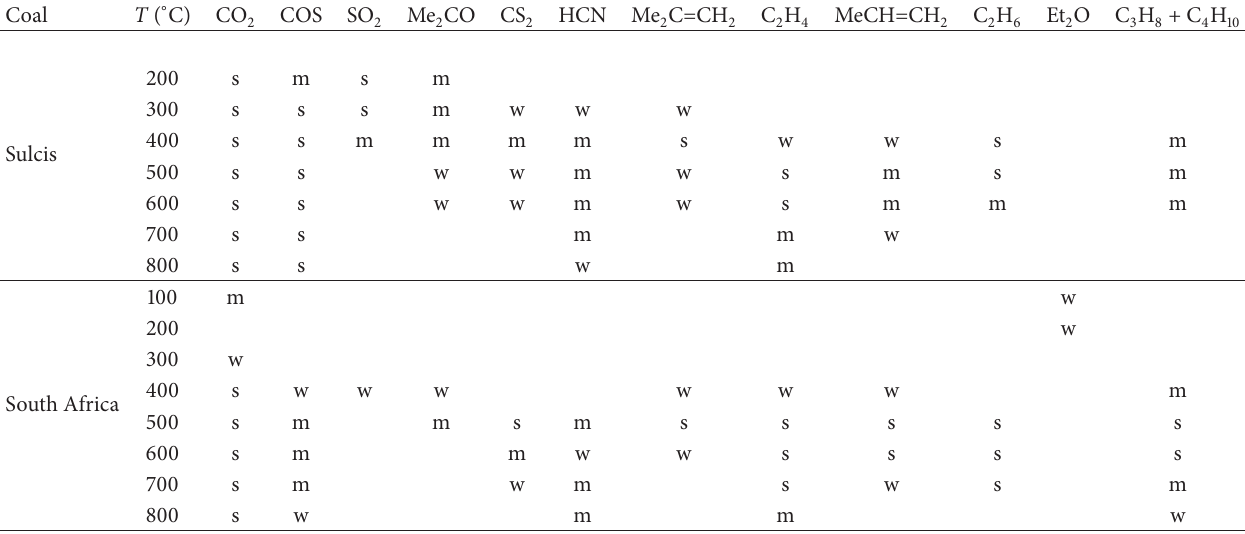
Table 4: Qualitative distribution of vapors collected in the cooling trap (c) with liquid nitrogen. Coal T ( ∘ C) CO